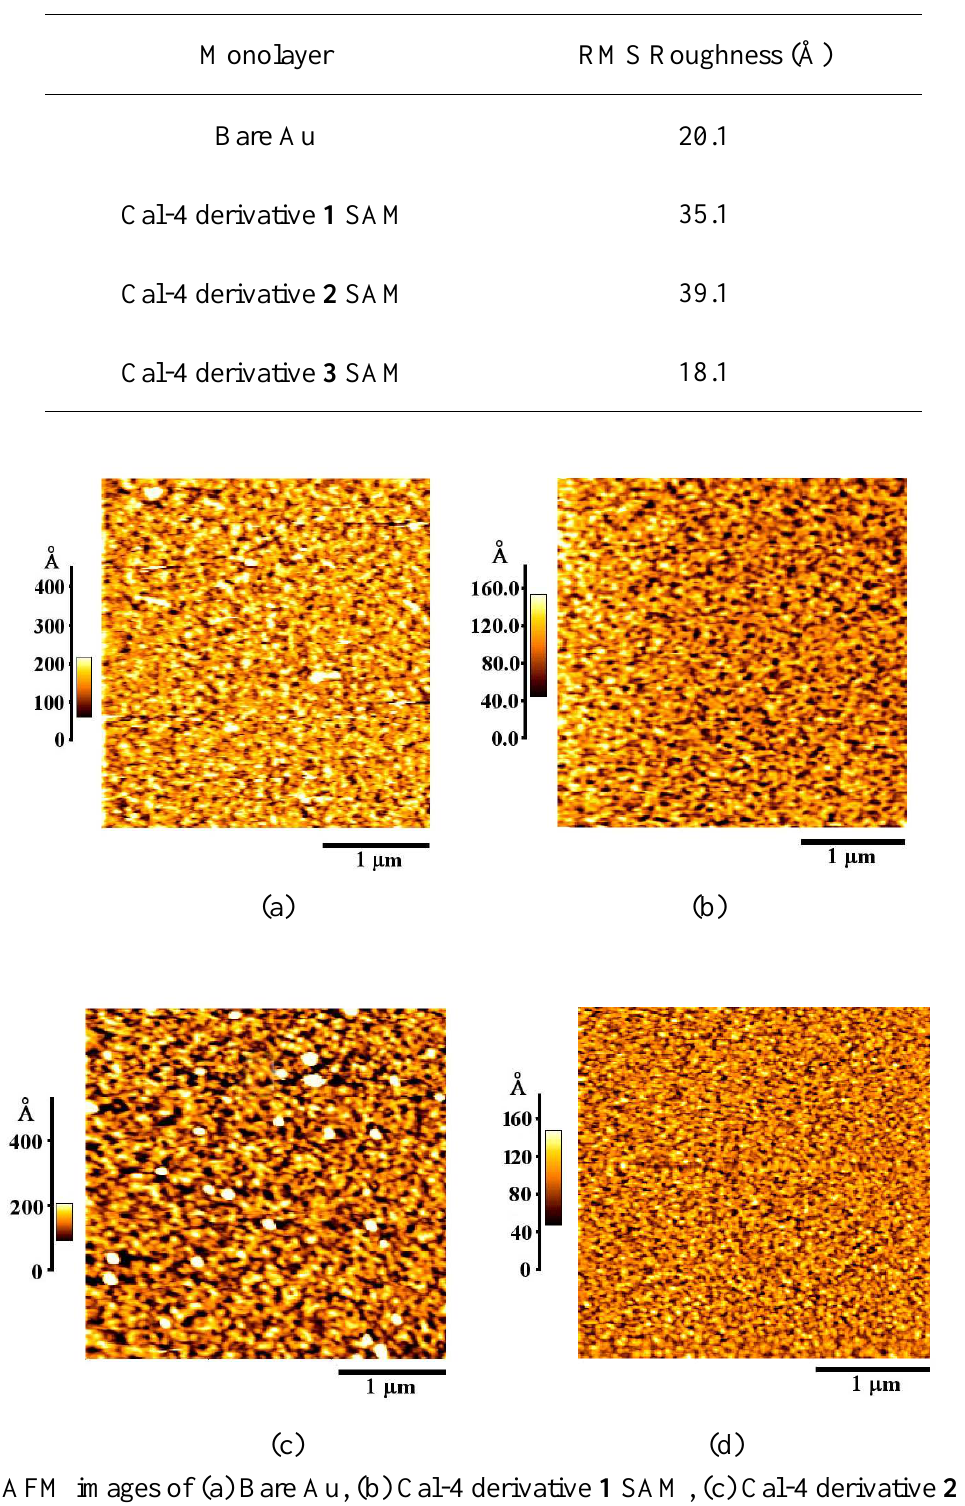
Figure 6 . AFM images of (a) Bare Au, (b) Cal-4 derivative 1 SAM, (c) Cal-4 derivative 2 SAM, and (d) Cal-4 derivative 3